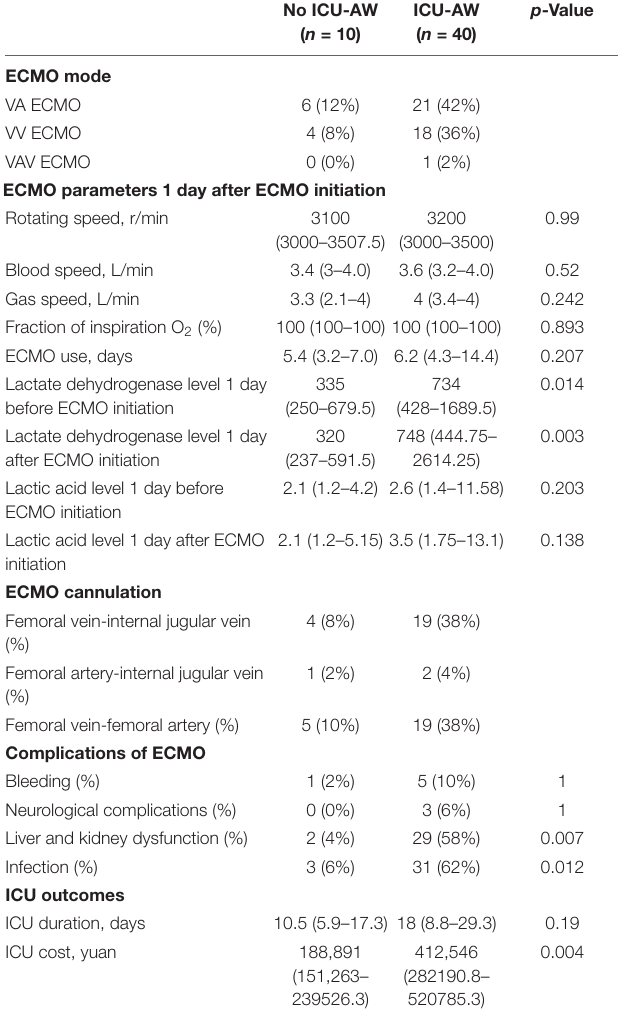
TABLE 3 | Extracorporeal membrane oxygenation